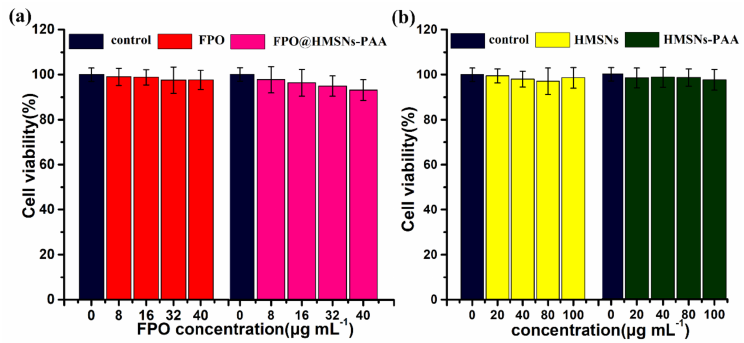
Figure 8. The cytotoxicity of ( a ) FPO, FPO@HMSNs-PAA; ( b ) HMSNs and HMSNs-PAA against 4T1 cells after 24 h co-incubation. When compared with the control group, all of the samples showed negligible cytotoxicity. Data were represented as means ± SDs ( n = 6).